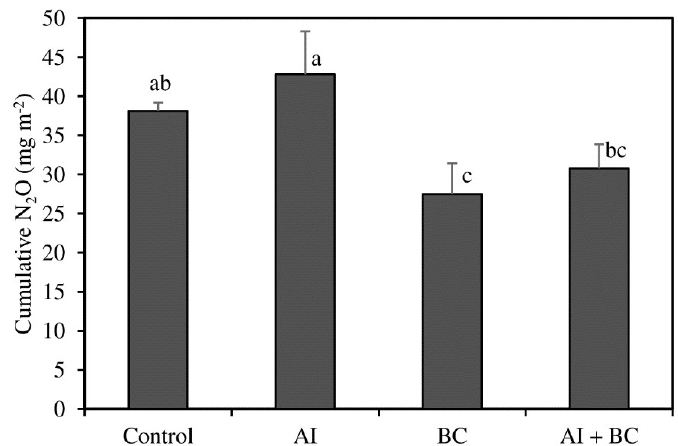
Figure 3. Cumulative N 2 O emissions affected by aerated irrigation (AI) and/or biochar (BC). Error bars indicate standard deviation ( n = 3). Means with the same letters are not significantly different at the P ≤ 5% level by the LSD test.